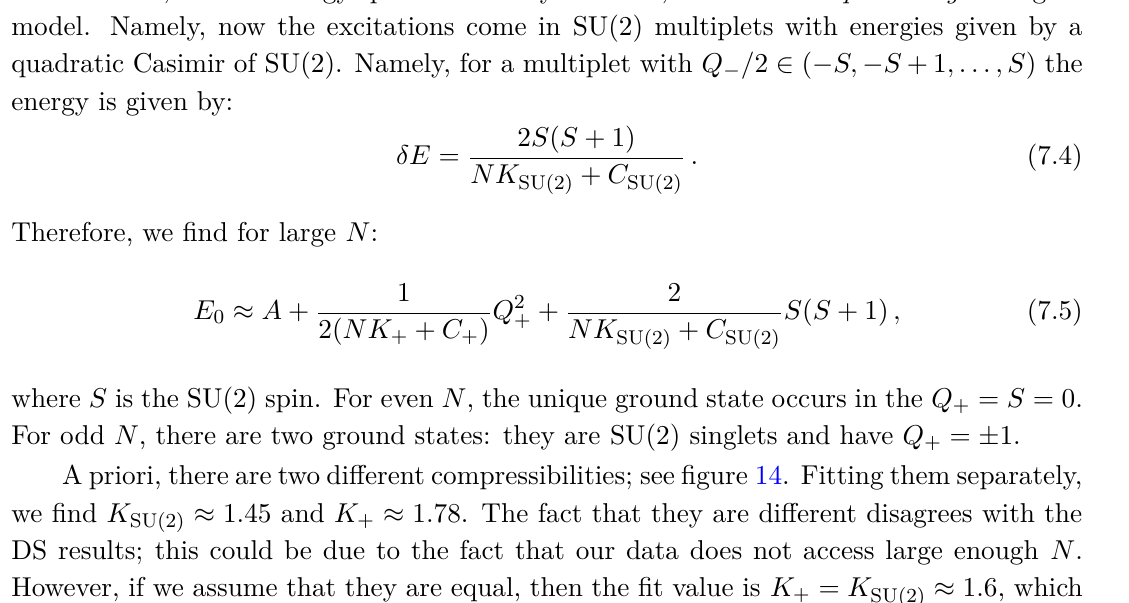
Q 2 + 2 S ( S + 1) , and plot B + 2 B + B SU(2) ≈ 1 . 45 SU(2)